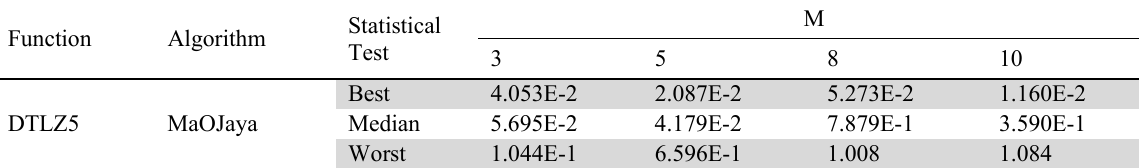
IGD values of DTLZ5 Function Function